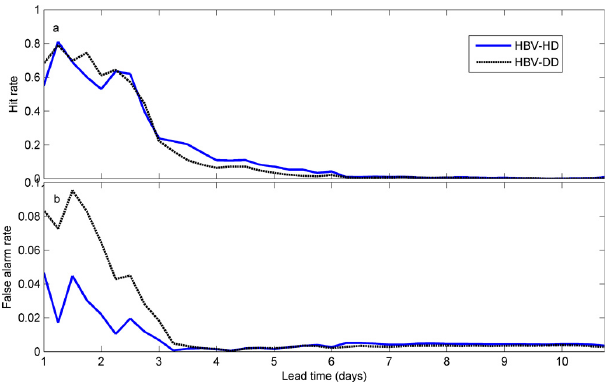
Fig. 5. Hit rate (a) and False alarm rate (b) as a function of lead time for HBV models calibrated and initiated by HP (blue lines) and DP (black dotted